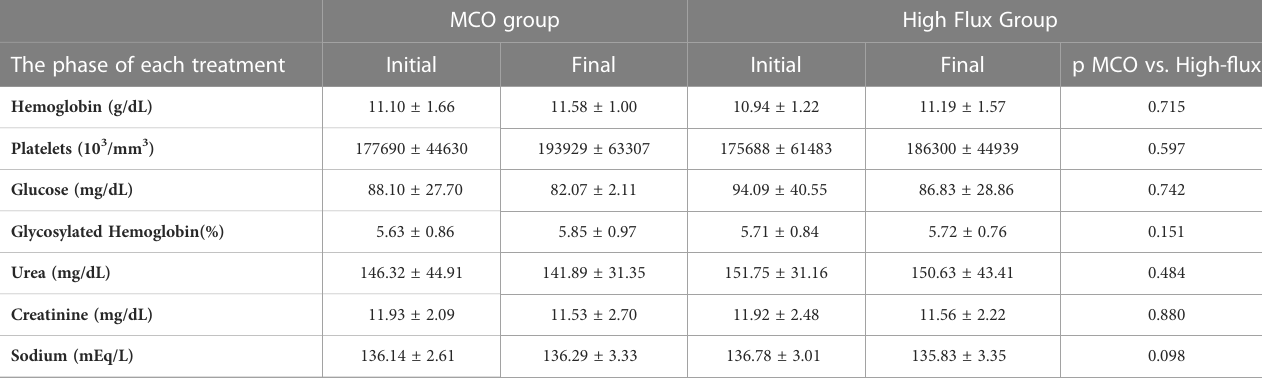
TABLE 2 Laboratory tests in MCO and High- fl ux groups before and after 12 weeks of treatment with MCO/High- fl ux